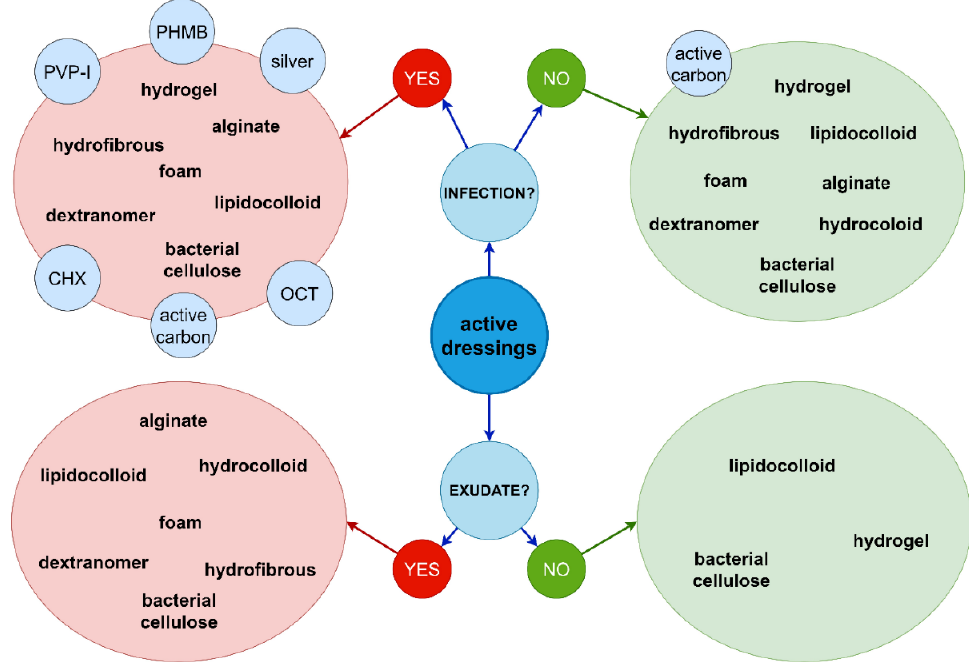
Figure 2. Examples of commercially available modern active dressings and their applications [84,86 – 96]. PHMB — polyhexanide; PVP-I — povidone-iodine; CHX — chlorhexidine; OCT — octenidine. PHMB—polyhexanide; PVP-I—povidone-iodine; CHX—chlorhexidine;